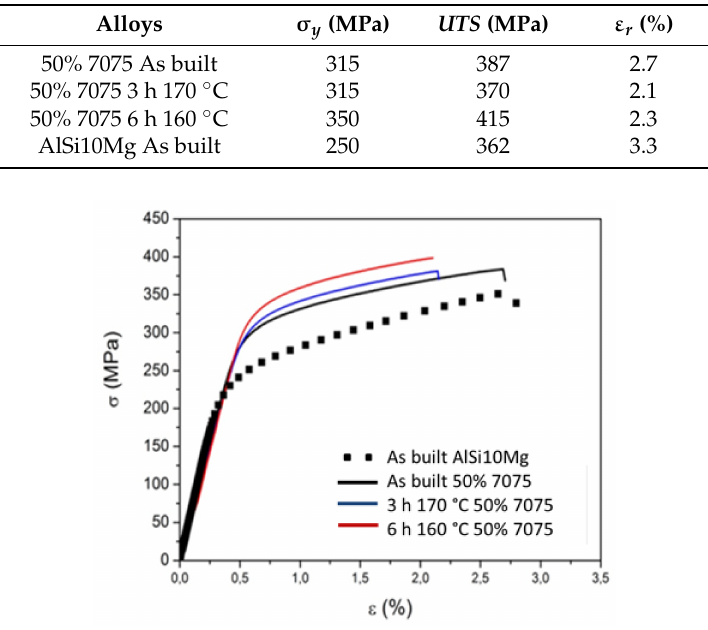
Figure 10. Tensile curves of 50% 7075 samples in the as-built state and aged in different conditions compared with the AlSi10Mg one in the as-built state.